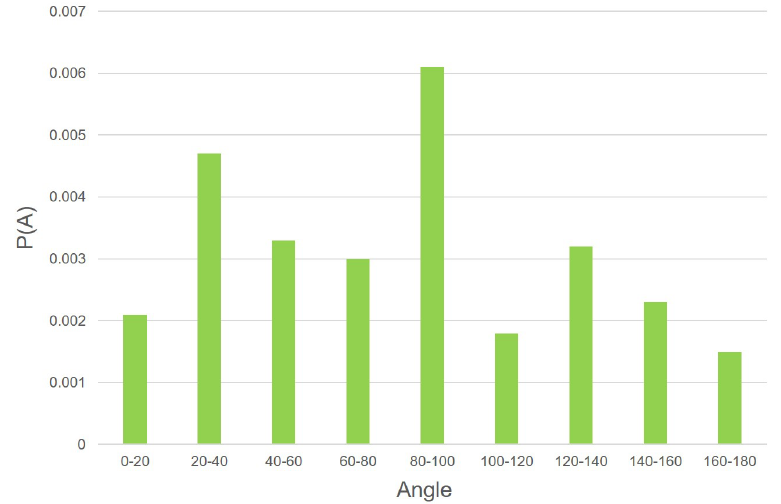
Figure 5. Average predicted angle deviation for different angles. The deviation value P ( A ) at extremely low values indicates that our approach to the predicted rotation angle is a valid method.